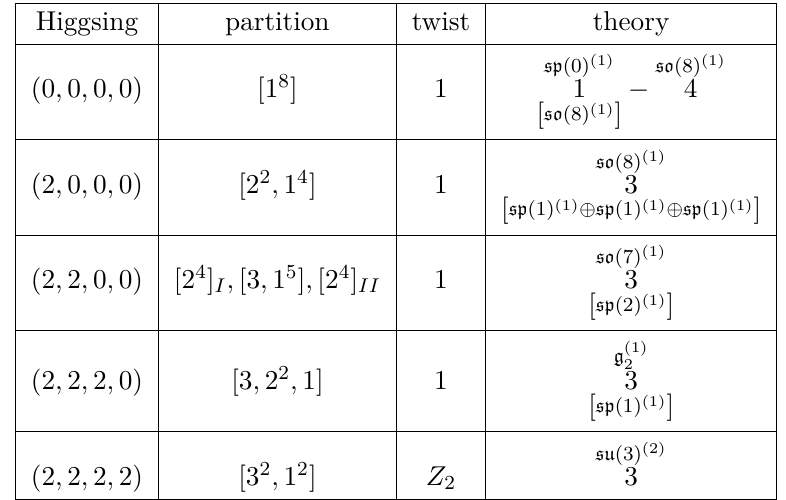
Table 1. Higgsings associated to SU(2) 4 of